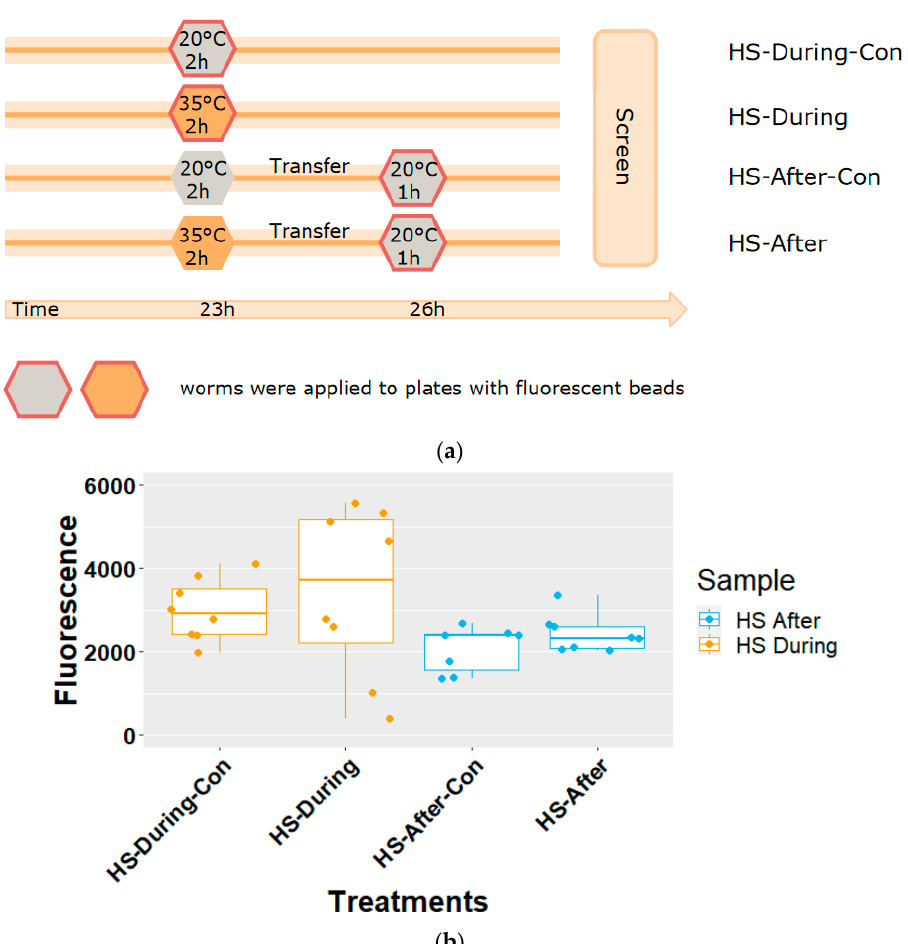
Figure 2. Food intake assay of C. elegans N2 during and after HS. ( a ) Timeline of food intake assay. ( b ) Assay result. HS-After: food intake after heat stress; HS-After-Con: control of HS-After; HS-During: food intake during heat stress; HS-During-Con: control of HS-During. Fluorescence: normalized fluorescence in pixel units. Dots: biological replicates.